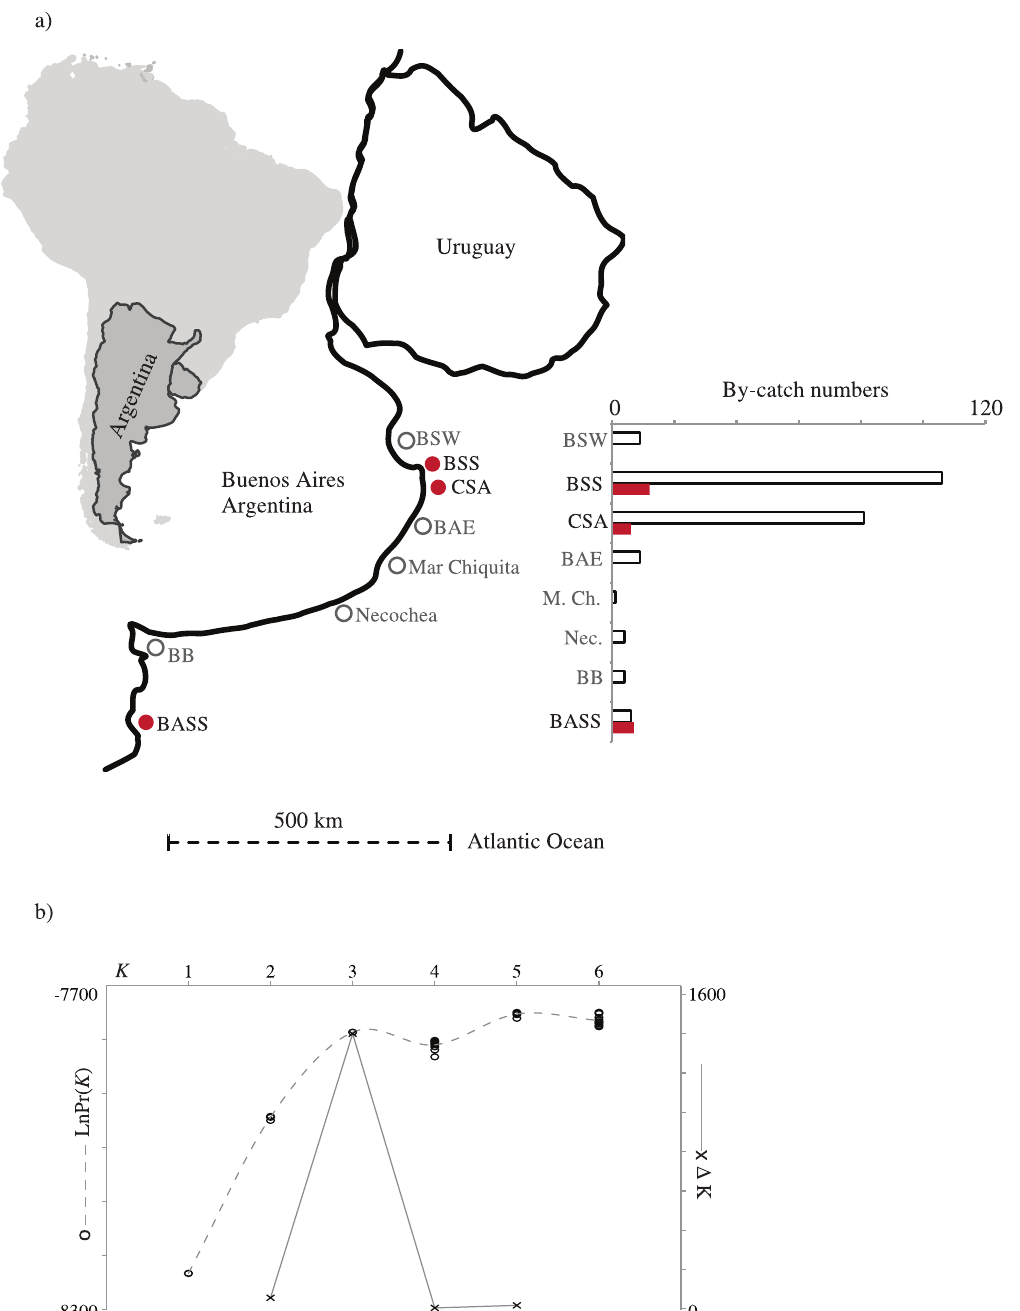
Figure 1. Study area and sampling effort. a) Study area map showing the frequency distribution of individual (empty bars) and simultaneous (solid red bars) incidental entanglements/capture release events in the Buenos Aires province, with the locations of the simultaneous events highlighted in red color. b) Population structure between BSS, CSA and BASS (Table S3). The graph displays the Log-likelihood of the data and the D K , plotted against the partition